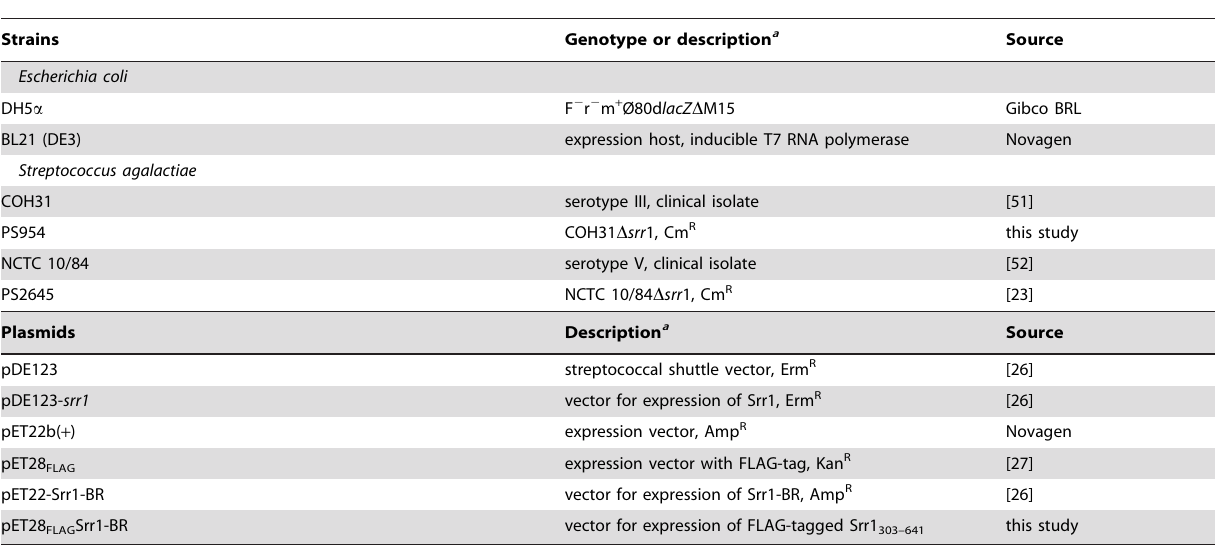
Table 1. Strains and